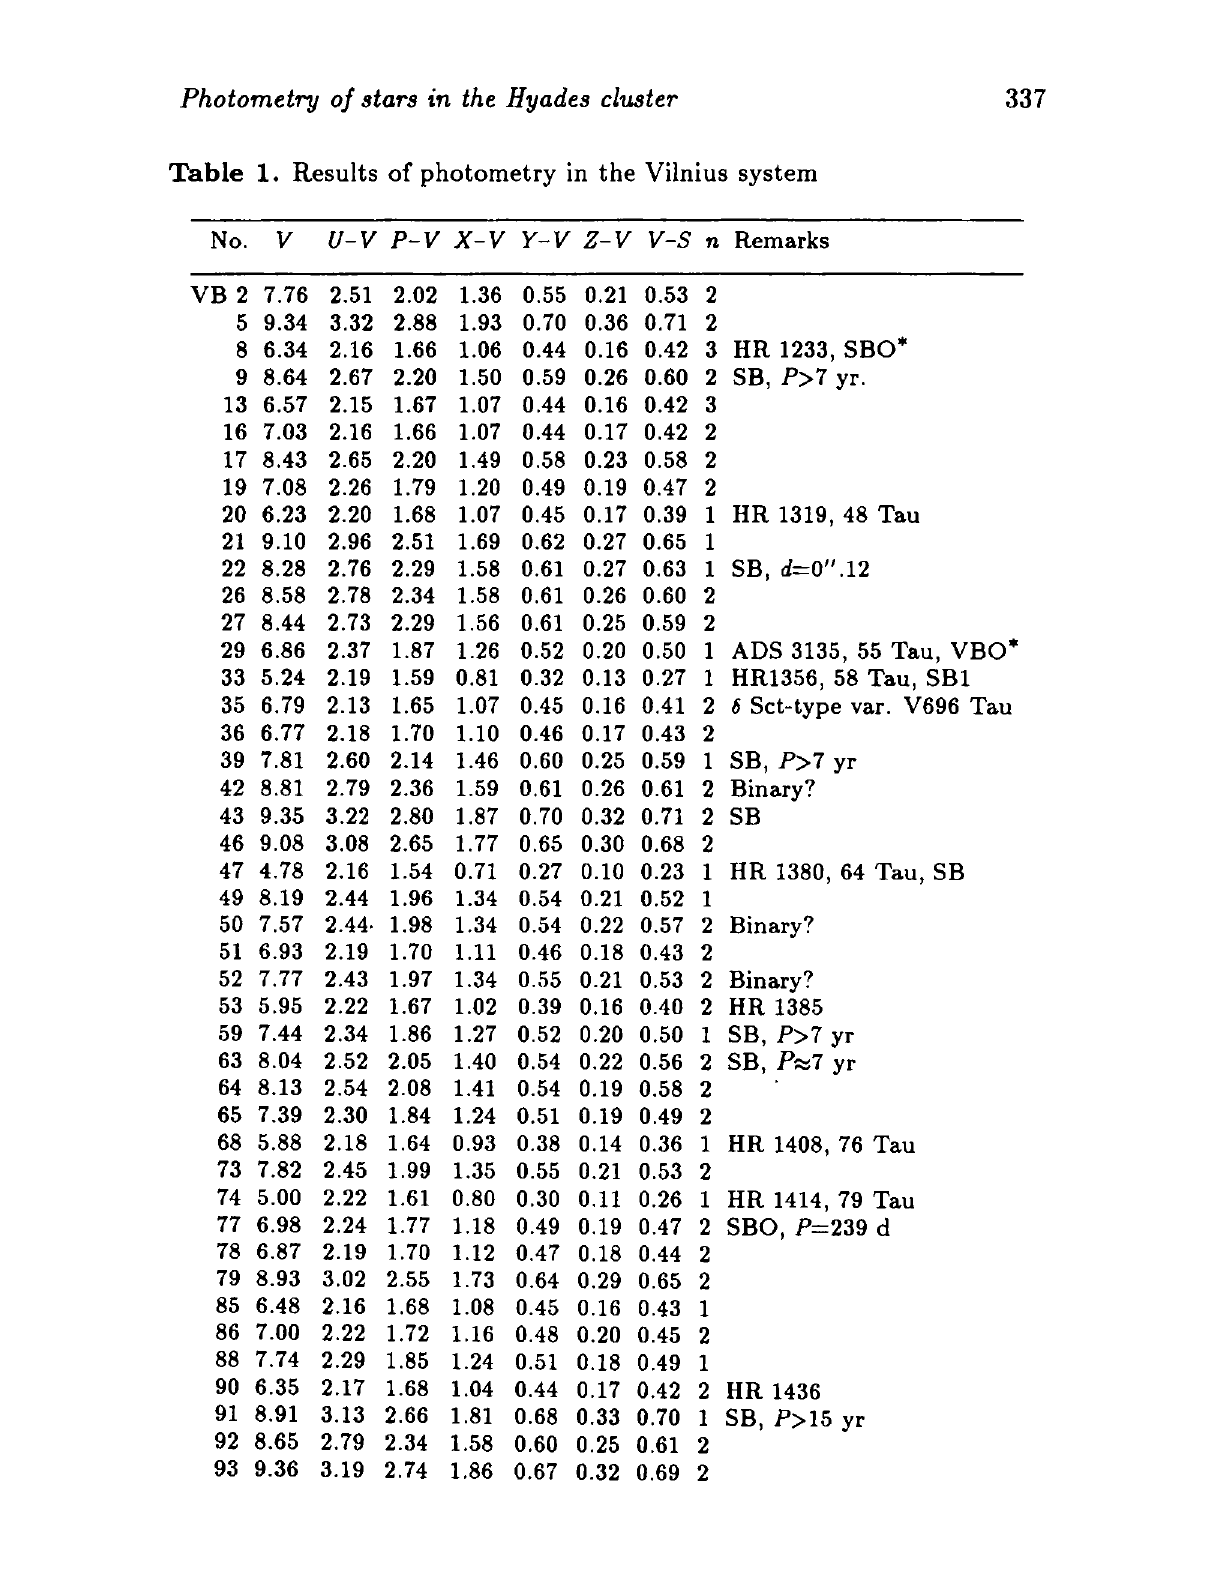
Table 1. Results of photometry in the Vilnius